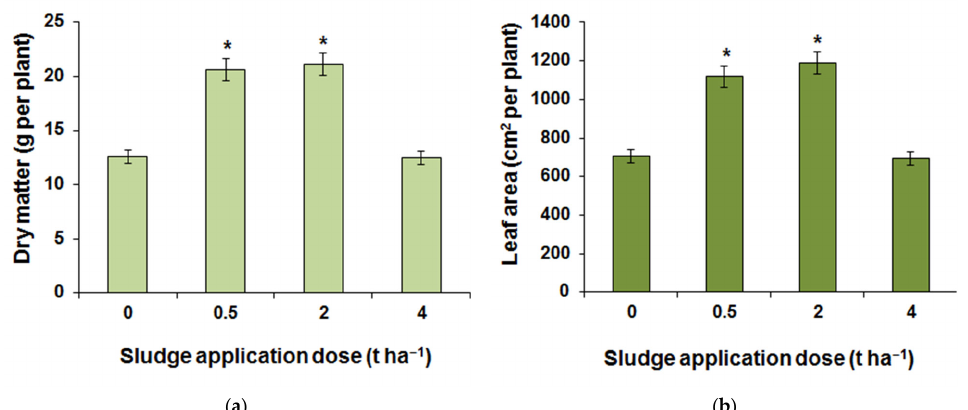
Figure 10. Indicators of photosynthetic activity of spring rapeseed plants: ( a ) Amount of dry matter; ( b ) Leaf area. n = 90. *—significant differences with the control.